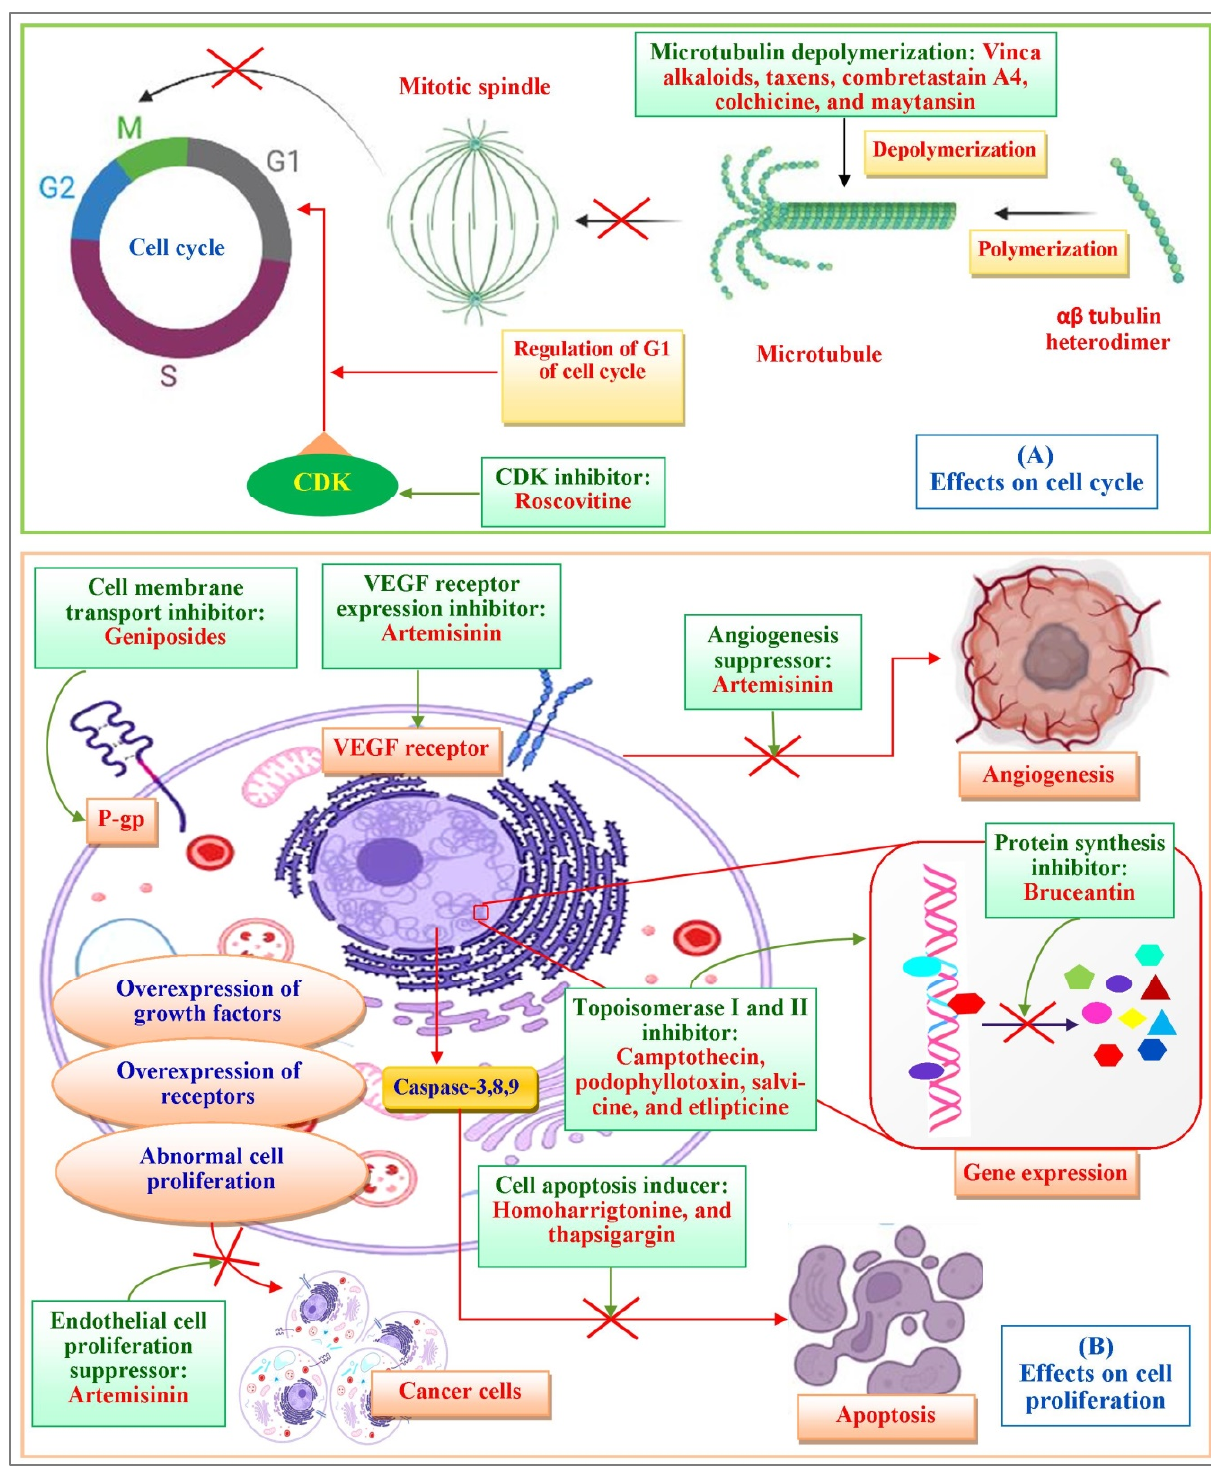
Figure 2. General mechanistic insight of anticancer drugs derived from plants. M, G1, G2, and S represent distinct phases of a cell cycle characteristic to specified functions or intervals; where M phase: mitosis cell division; S phase: DNA synthesis; G1 (gap 1) phase: gap between completion of M phase and initiation of S phase; and G2 (gap 2) phase: gap between completion of S phase and initiation of M phase.